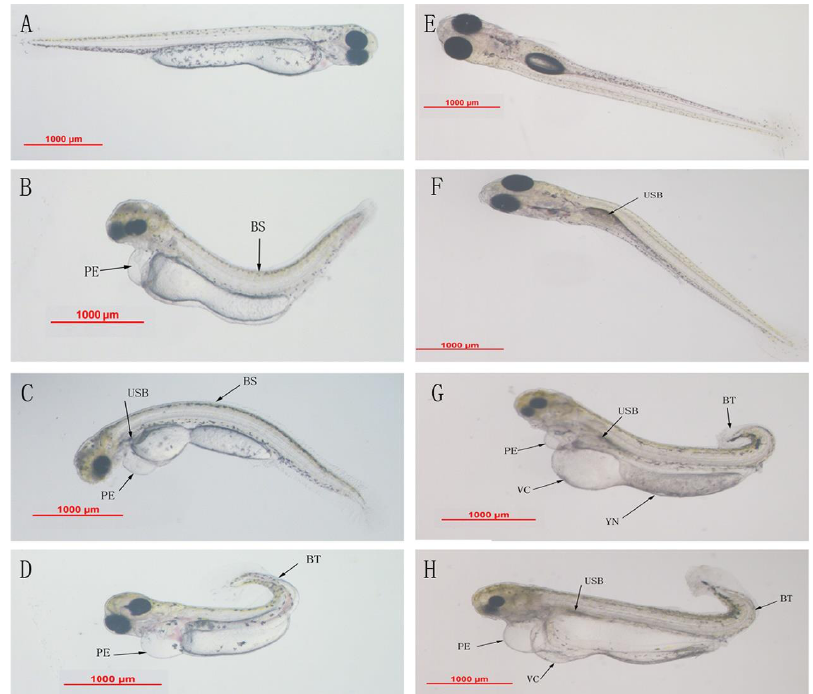
Figure 2. Microscopic images of newly hatched rare minnow larvae ( A – D ) and larvae at 3 d post hatch ( E – H ): ( A ) normal newly hatched larva, ( B – D ) Hg 2+ exposed newly hatched larva with peri- cardial edema (PE), bent spine (BS) and bent tail (BT), ( E ) normal larva at 3 d post hatch, ( F – H ) Hg 2+ - exposed larva with uninflated swim bladder (USB), pericardial edema (PE), yolk sac edema (YSE), bent spine (BS), bent tail (BT) and yolk sac necrosis. According to the results, Hg 2+ exerted no effects on the spontaneous movements at no more than 0.10 mg/L; the LOEC and NOEC values of Hg 2+ to hatching rate at 96 hpf were 0.10 and 0.05 mg/L, respectively. The LOEC and NOEC values of Hg 2+ to heartbeat, mortality, malformation rate, and body length of the survived larvae were 0.05 and 0.01 mg/L, respectively (Table 5). Table 5. LOEC and NOEC values of Hg 2+ to rare minnow at embryo and sac-fry stages. Endpoints LOEC (mg/L) NOEC (mg/L) Spontaneous movements (36 hpf) >0.1